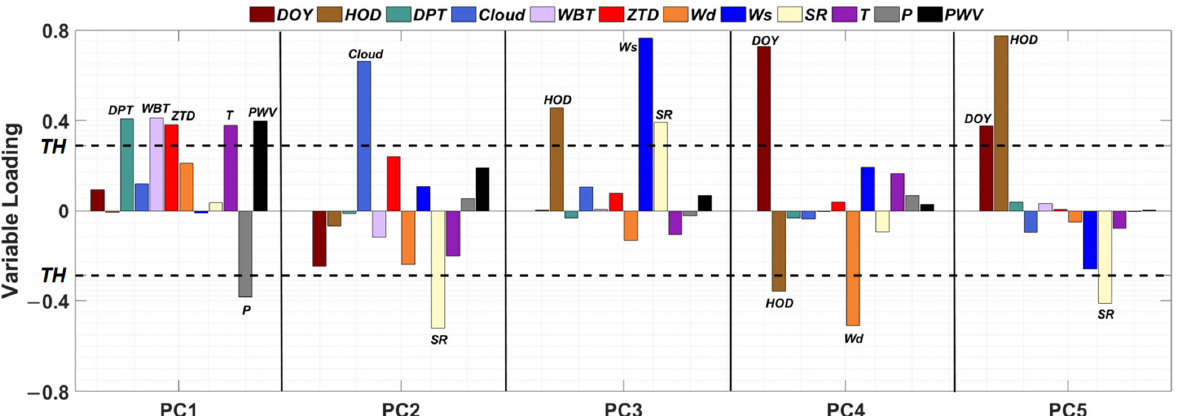
Figure 5. Loadings of each of the twelve variables for the five main principal components. The dotted lines denote the predetermined loading threshold values (denoted by “ TH ”); while the solid lines are used to separate the five principal components shown in this figure.